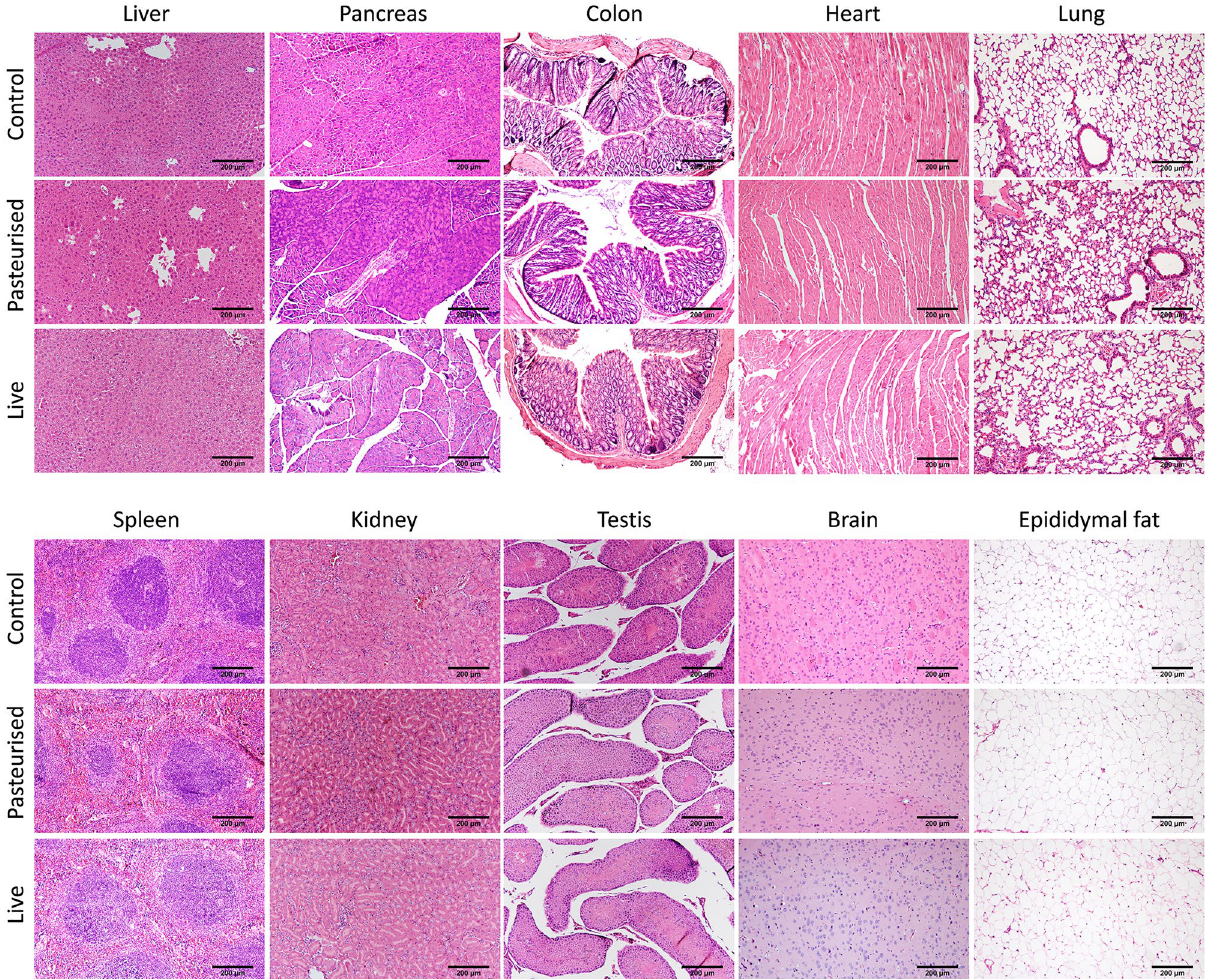
Figure 4. Representative histological haematoxylin–eosin stained sections of murine organs of control mice (top) and after administration of pasteurized (middle) or live (bottom) P. copri (liver, pancreas, colon, heart, lung, spleen, kidney, testis, brain and epipidymal fat). Scale bar = 200